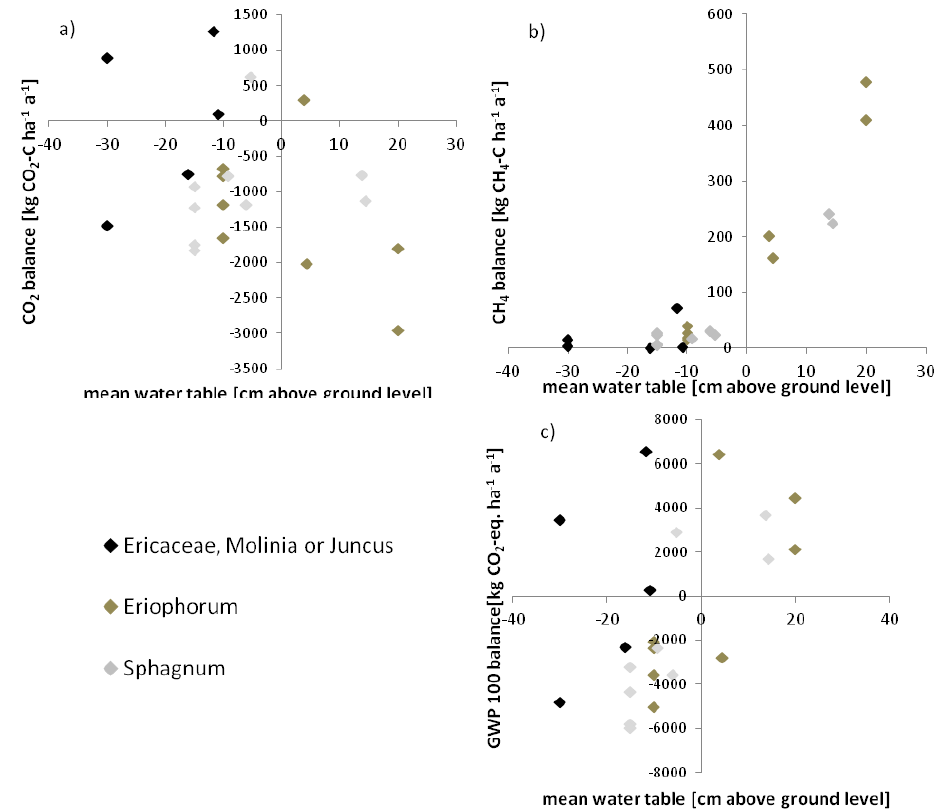
Figure 5. Yearly gas exchange balances versus mean water level of rewetted bogs in temperate zone: categories according to dominant vegetation ( Ericaceae -, Molinia -, or Juncus -dominated; Eriophorum -dominated; Sphagnum -dominated). (a) Yearly NEE balance versus mean water level; (b) yearly CH 4 balance versus mean water level; (c) yearly GWP100 balance versus mean water level. Only data from rewetted bogs in the temperate zone are included; the data used come from this paper, own unpublished data, Nieveen et al. (1998), Drösler (2005), Bortoluzzi et al. (2006) and Beetz et al. (2013). Please note: in general, values of flux rates and water level are given in the text or in tables of the corresponding publications. If values of water level are not given, but only presented in the form of a figure, then mean water level was estimated from the figures in the corresponding